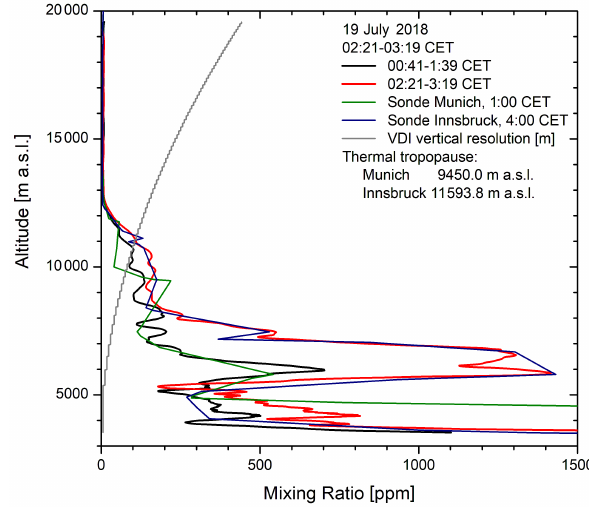
Figure 12. Calibration of the measurements on 19 July 2018: the profile derived from the first measurement agrees better with the 01:00CET sonde data from Munich. The mixing ratios for the sec- ond measurement almost coincide with those from the later sonde launch at the airport of Innsbruck. The average laser pulse energy was 380mJ